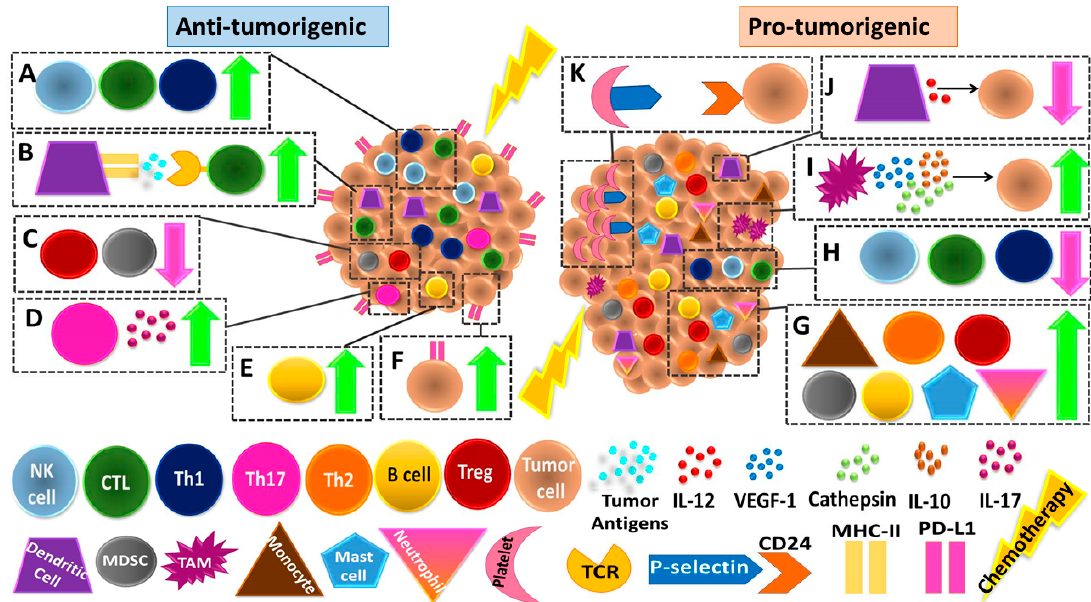
Figure 1. Pro-tumorigenic and anti-tumorigenic roles of BMDCs in the chemotherapy-treated microenvironment. The illustration provides examples describing the anti-tumorigenic (left panel, A – F ) and pro-tumorigenic (right panel, G – K ) host responses to chemotherapy, and their e ff ects on the tumor microenvironment of di ff erent tumor types. Specifically, the anti-tumorigenic host e ff ects consist of elevated levels of Th1, NK and CD8 + cytotoxic T cells (CTLs) in the TME ( A ); elevated tumor antigens presentation by dendritic cells to CTLs, further activating them ( B ); reduced infiltration of MDSCs and Tregs ( C ); increased IL-17 production by Th17 T cells ( D ); increased infiltration of B cells to the TME ( E ); and elevated expression of PDL-1 by tumor cells ( F ). On the other hand, the pro-tumorigenic host e ff ects involve immune host cells including monocytes, T helper 2 (Th2) cells, T regulatory cells (Tregs), myeloid derived suppressor cells (MDSCs), B cells, mast cells and neutrophils, which are upregulated in the TME ( G ); immune host cells including T helper 1 (Th1), natural killer (NK) cells, and CD8 + cytotoxic T cells are downregulated in the TME ( H ); tumor-associated macrophages (TAMs)secreting IL-10, cathepsins and VEGF-C are infiltrating the treated TME further supporting tumor re-growth and metastasis ( I ); IL-12 production levels are downregulated in dendritic cells following chemotherapy treatment, resulting in decreased granzyme B production by CTLs, further contributing to tumor growth and metastasis ( J ); and activated platelets aggregate in the TME, further binding to tumor cells via P-selectin-CD24 axis ( K ).